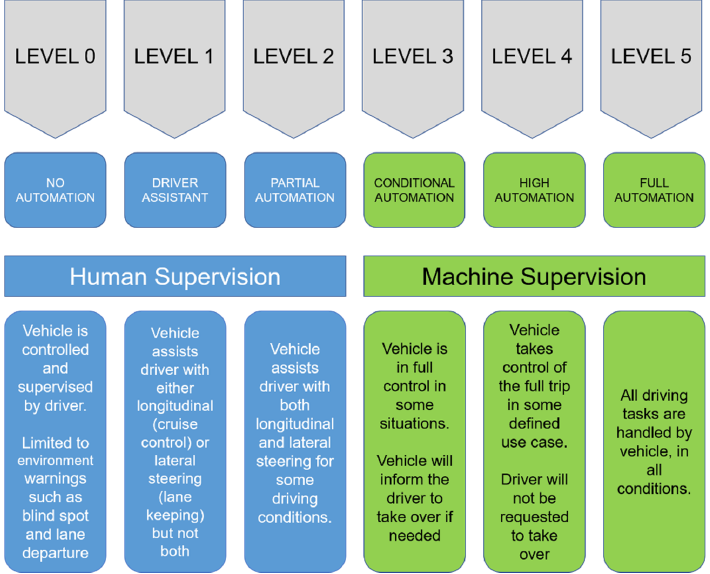
Figure 1. The six levels of autonomous vehicles as described by the Society of Automobile Engineers (SAE) [3], their definitions, and the features in each level.